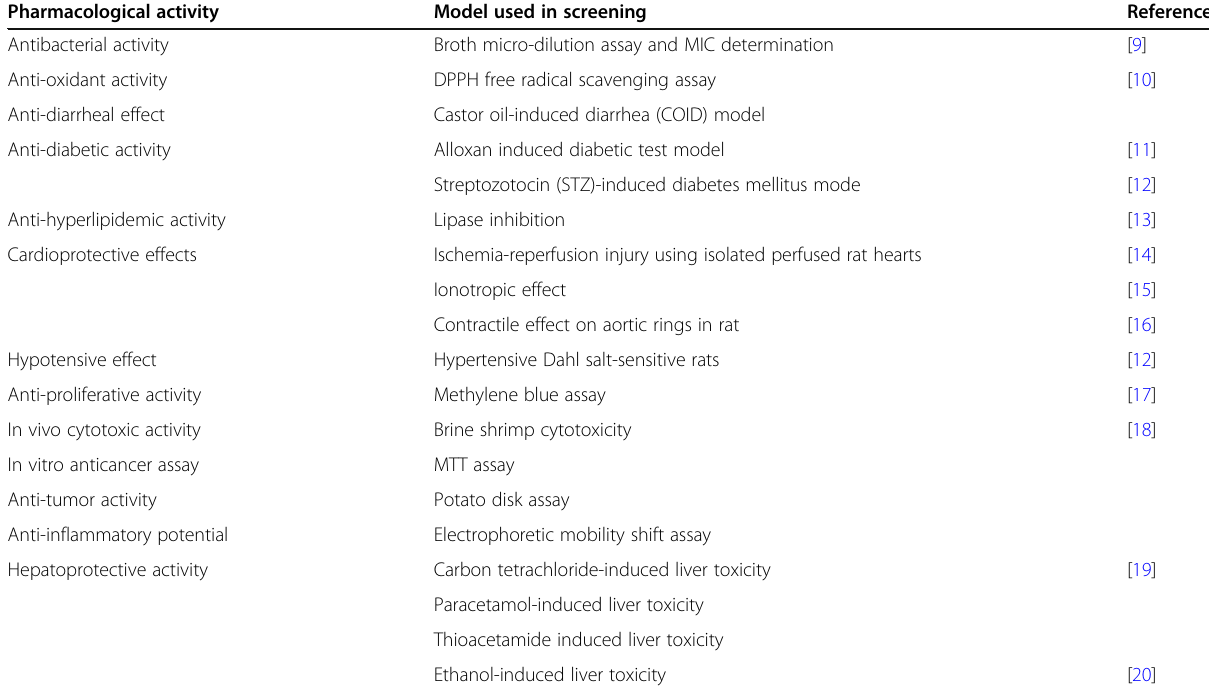
Table 1 Pharmacological activities of Psidium guajava leaves Pharmacological activity Model used in